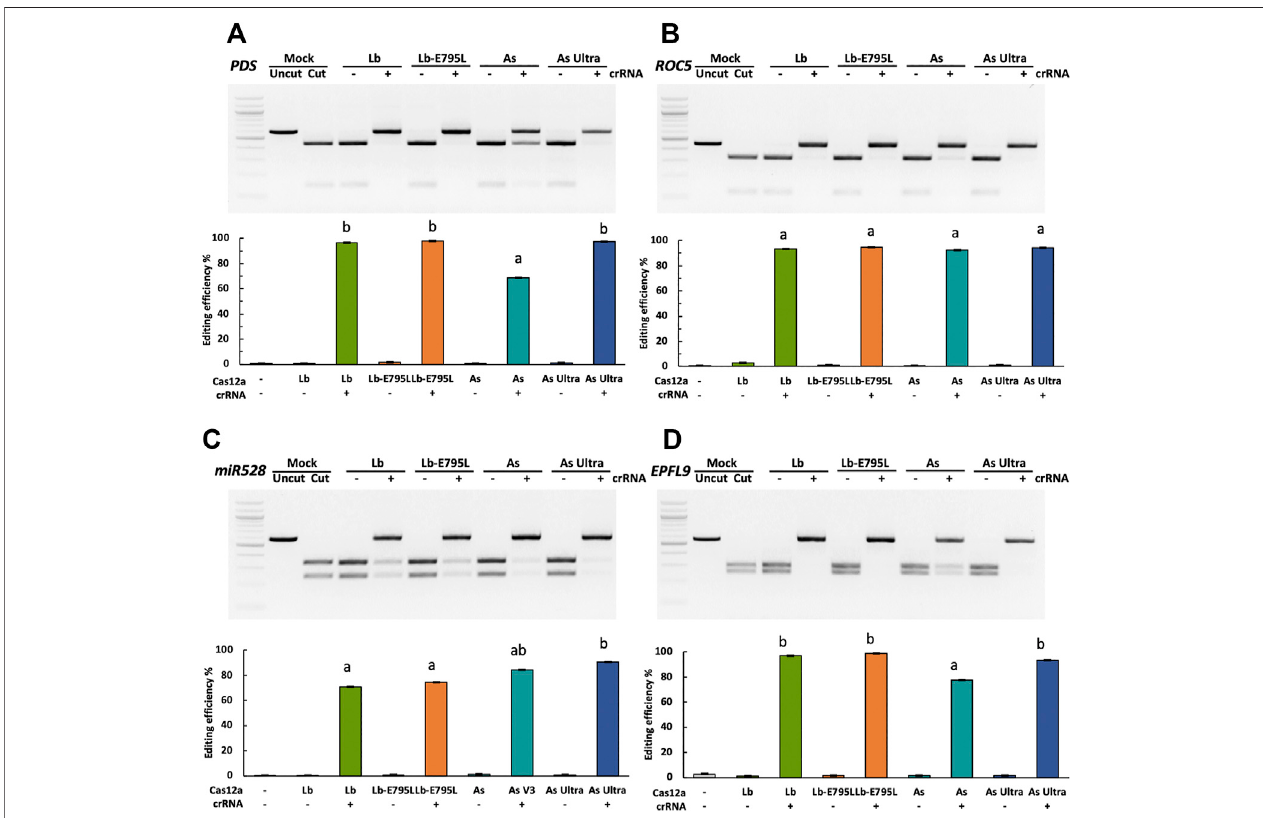
FIGURE 1 | Engineered Cas12a variants show enhanced activities in rice cells with RNP delivery. Editing ef fi ciencies of four Cas12a variants in rice cells with RNP delivery at the OsPDS (A) , OsROC5 (B) , OsmiR528 (C) , and OsEPFL9 (D) sites at 32 ° C. Editing ef fi ciencies are calculated using the RFLP assay. Data are presented as mean values ±SEM of three biologically independent replicates. Editing ef fi ciencies of four Cas12a variants at each target site are compared using Tukey ’ s Honest Signi fi cant Difference (HSD) test. Treatments with the same letter are not signi fi cantly different when α = 0.05.